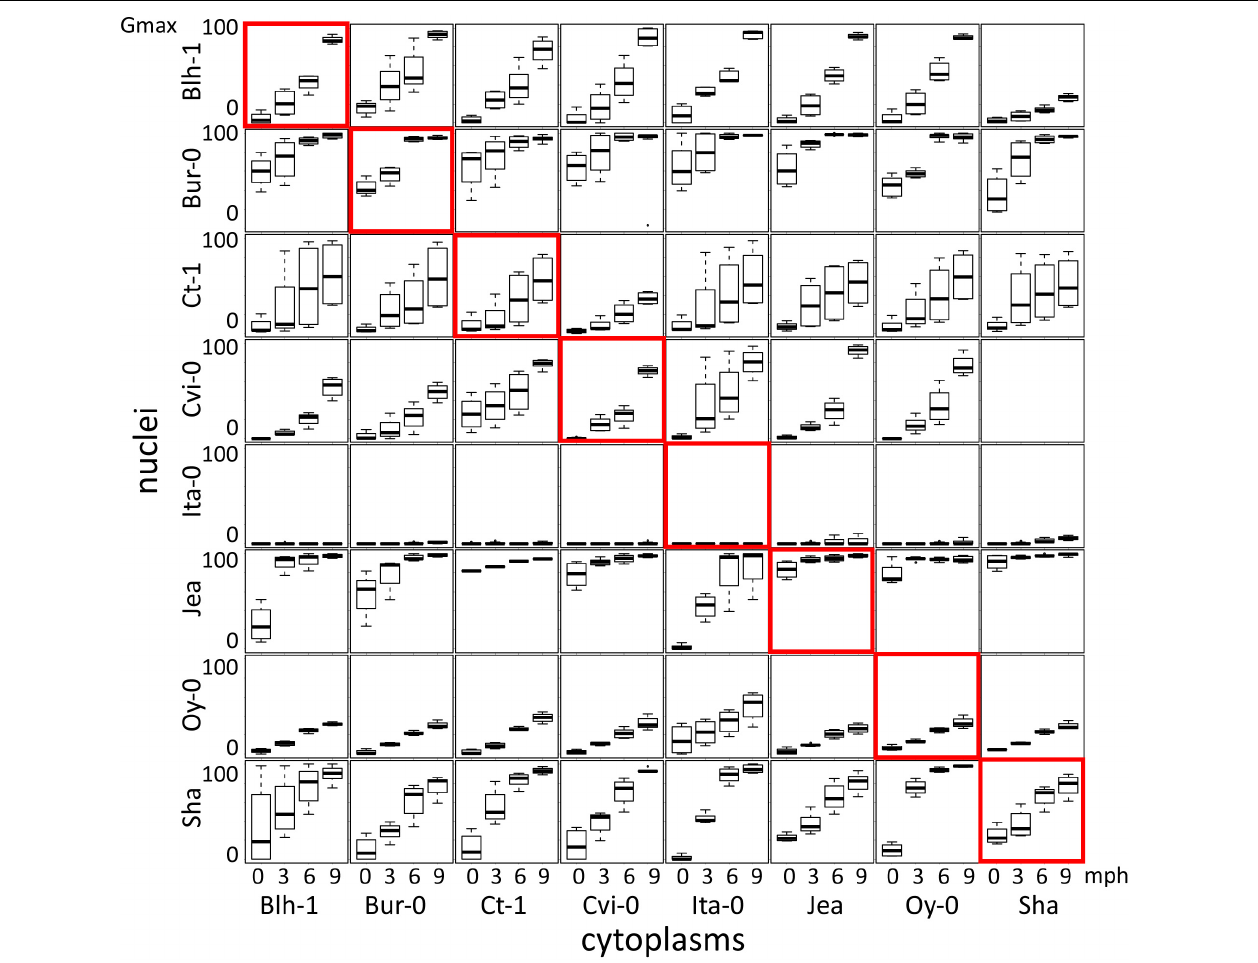
FIGURE 1 | Dormancy release during after ripening in cytoline series. Each panel shows boxplots of the maximum germination percentage at 15 ◦ C for one cytonuclear combination 0, 3, 6, and 9 months after harvest (mph). Rows present genotypes sharing their nucleus and columns those sharing their cytoplasm. Natural accessions are framed in red. The [Sha]Cvi-0 cytoline could not be tested due to the small amount of seeds obtained by hand pollination on this male-sterile genotype.